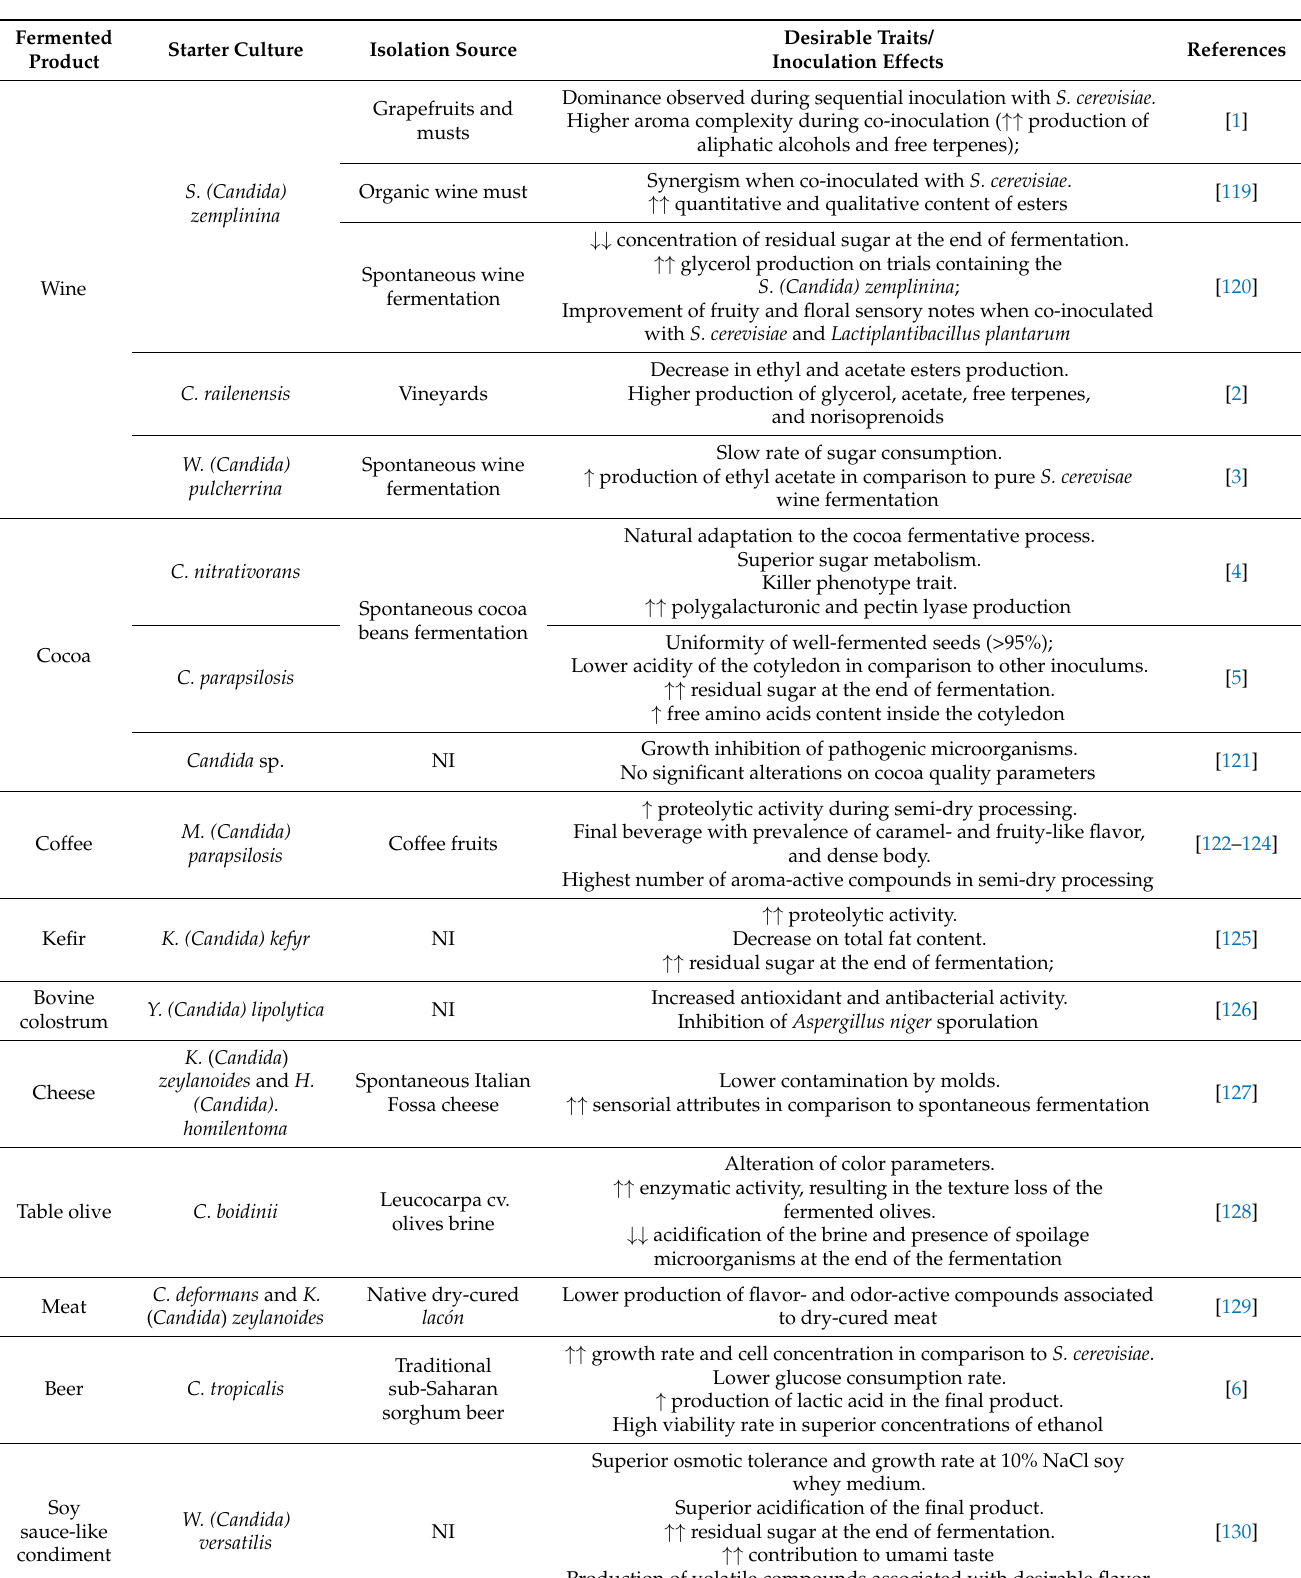
Table 2. Selected Candida starter cultures, isolation source, and impacts over the sensorial and functional aspects of economically relevant fermented foods and